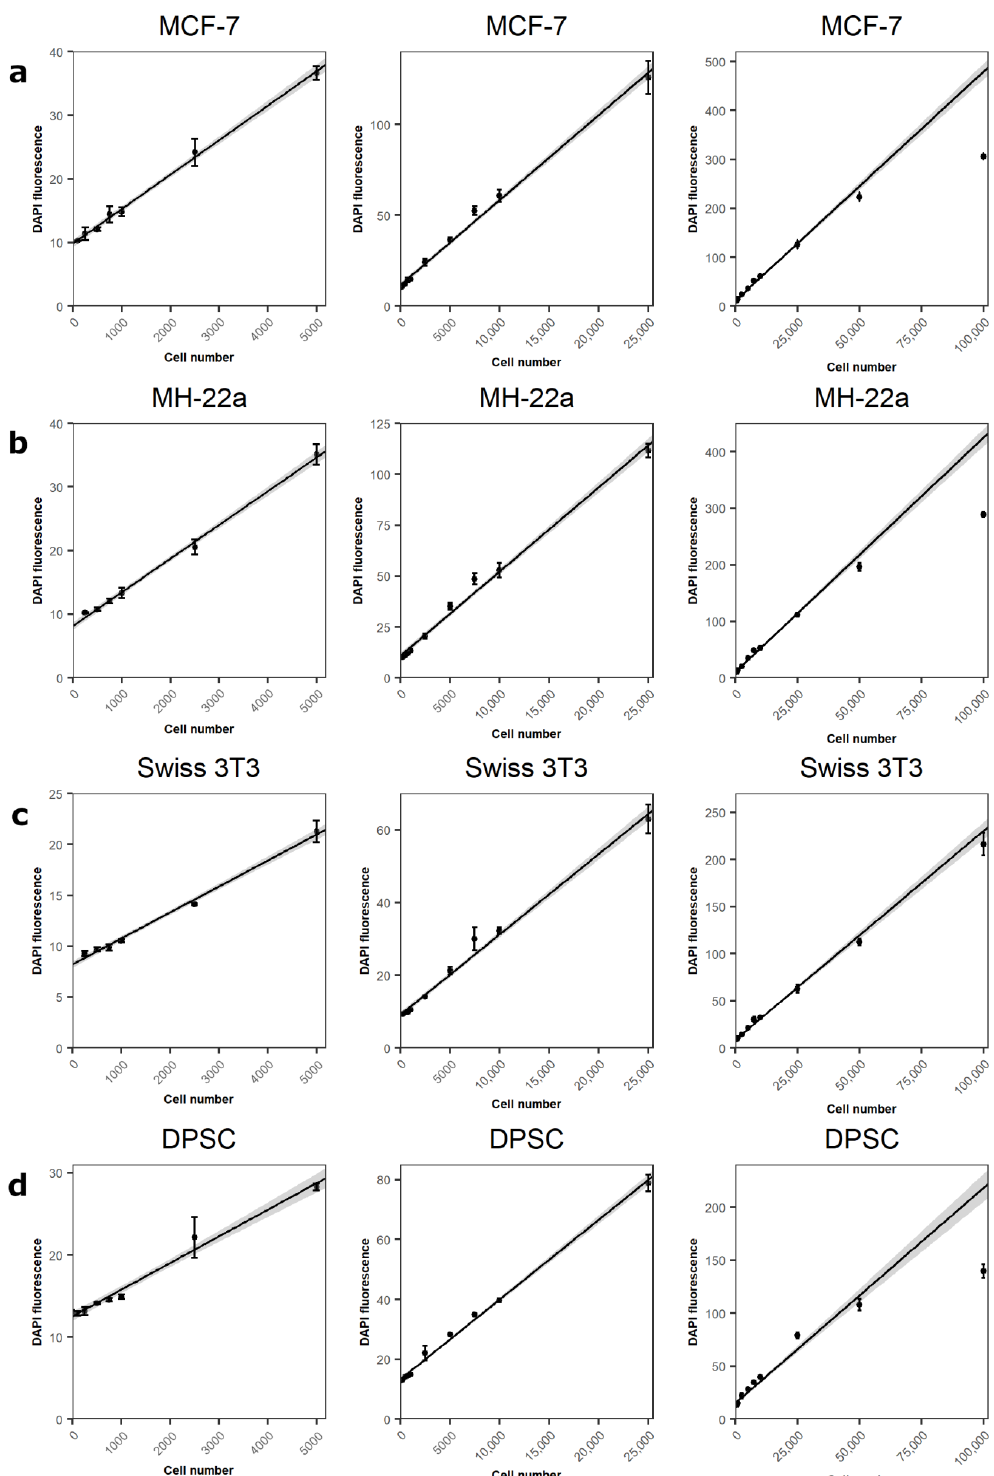
Figure 3. Dependence of DAPI fluorescence on the cell number. Cell numbers range from 200 to 5000 in the first column, from 200 to 25,000 in the second, and from 200 to 100,000 in the third. ( a ) MCF-7; ( b ) MH-22a; ( c ) Swiss 3T3 cell lines; ( d ) dental pulp primary stem cells (DPSC). Values in graphs are shown as mean ± SD. Lines are linear regression models comprised from the linear part of the graph—from 200 to 25,000 cells lysate DAPI fluorescence intensity data. n =